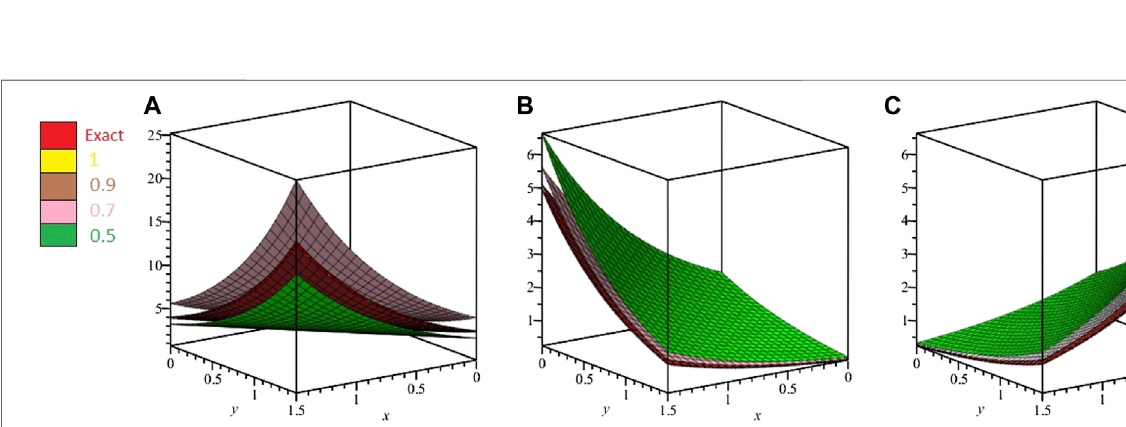
Frontiers in Physics |